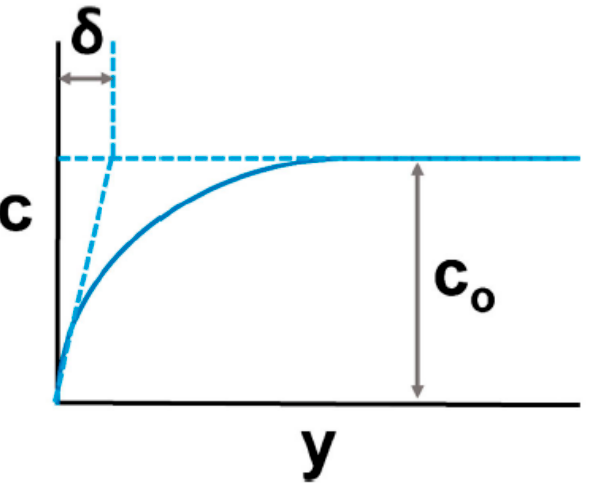
Figure 13. Graph showing acceptor concentration as a function of distance from the electrode, (after Wagner [120]).